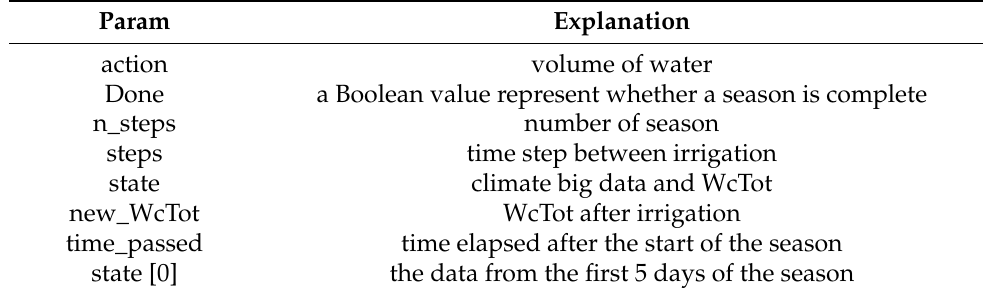
Table 11. The parameters used in Algorithm